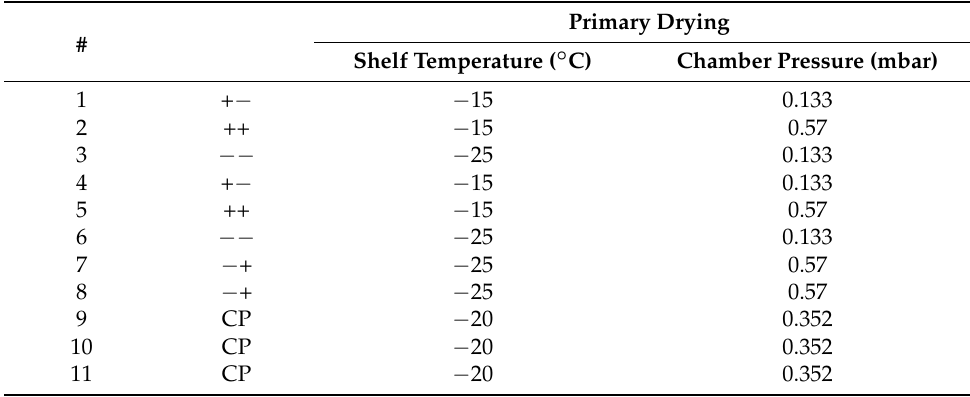
Table 2. Experimental design of experiments.